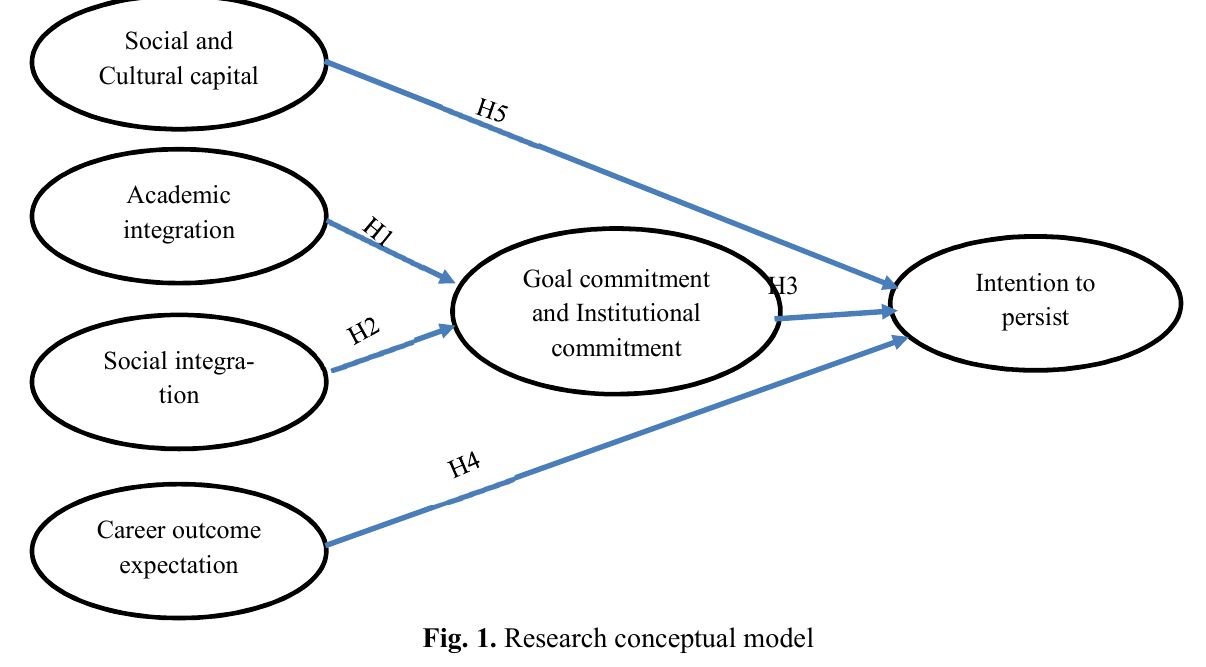
Fig. 1. Research conceptual